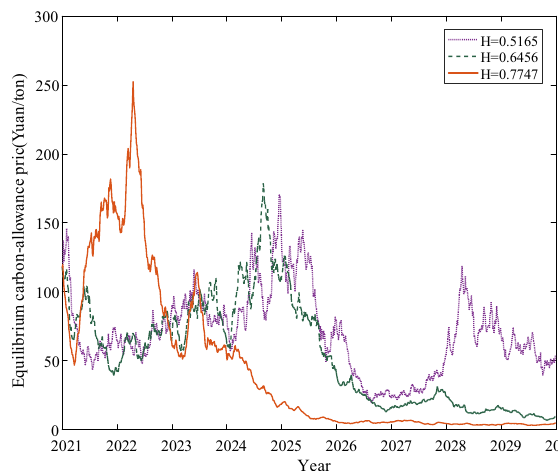
Fig. 8 Equilibrium prices of carbon allowances corresponding to different Hurst exponents